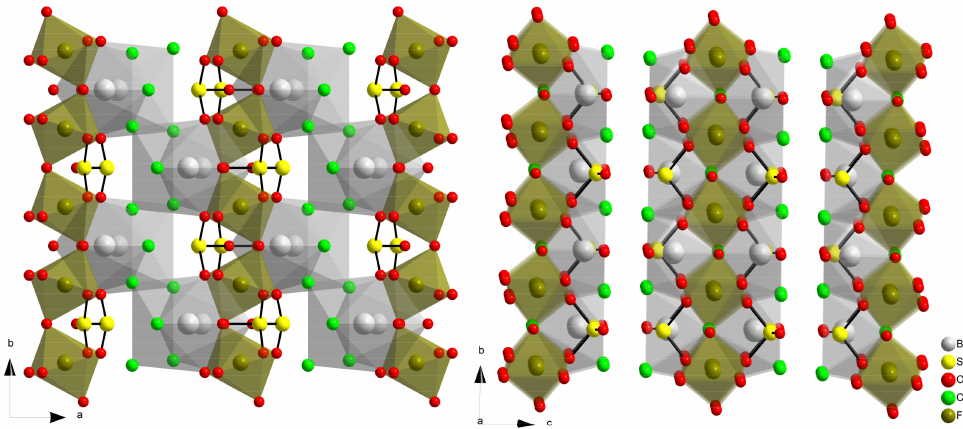
Figure 11. The view on [FeO 6 ] octahedra chains decorated by Bi polyhedra and SeO 32– groups in the crystal structure of Bi 2 Fe(SeO 3 ) 2 OCl 3